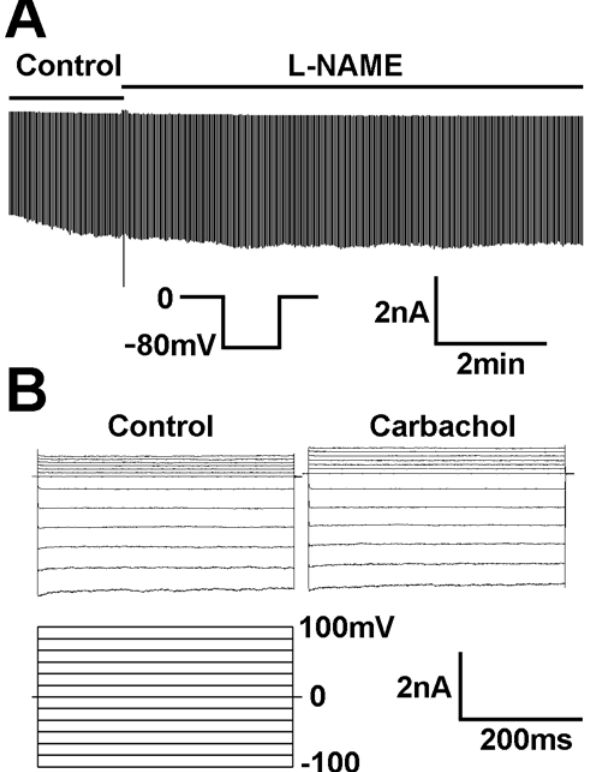
Fig 10. The effects of carbachol and L-NAME on these currents. (A) The Kir currents in PAECs were insensitive to the M receptor agonist carbachol (1 μ M). (B) eNOS inhibitor L-NAME (10 μ M) had no effect on the current